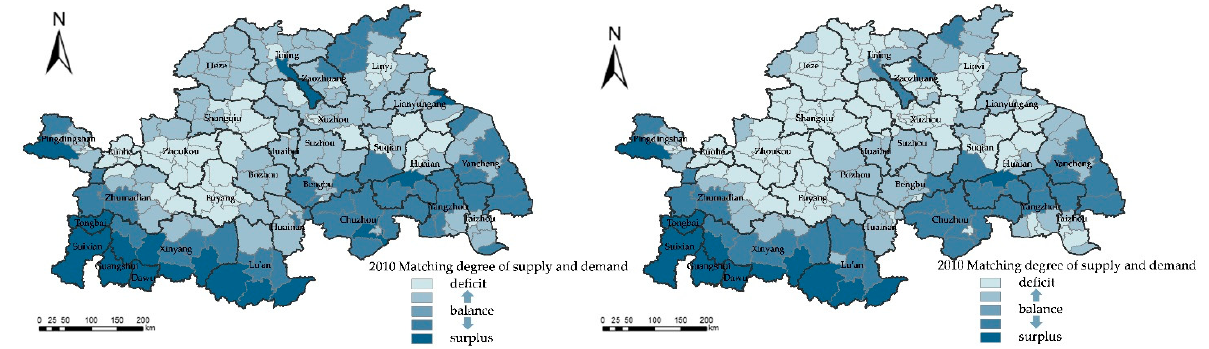
Figure 6. Distribution of the supply and demand index of ecosystem services in the Huai River Basin.